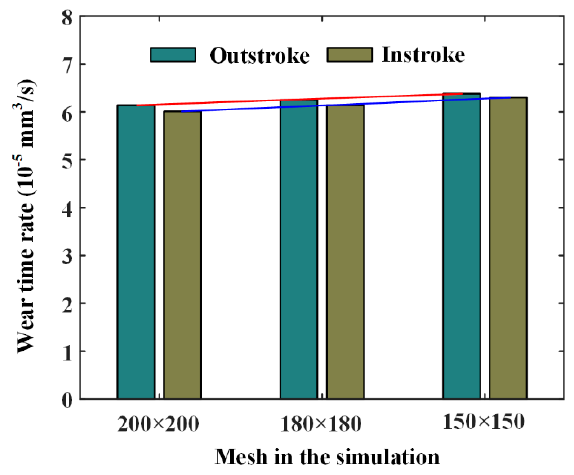
Figure 17. Wear rates under di ff erent simulation meshes.